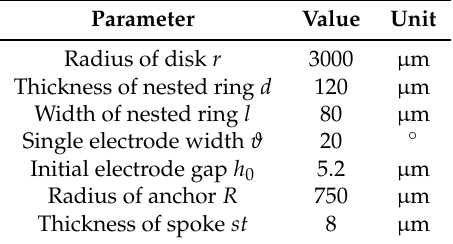
Table 1. Structure parameter dimension of the